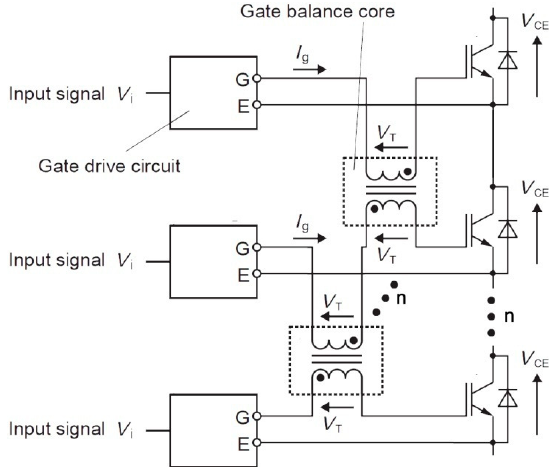
Figure 3. Control structure with a gate balancing core for parallel firing signals.